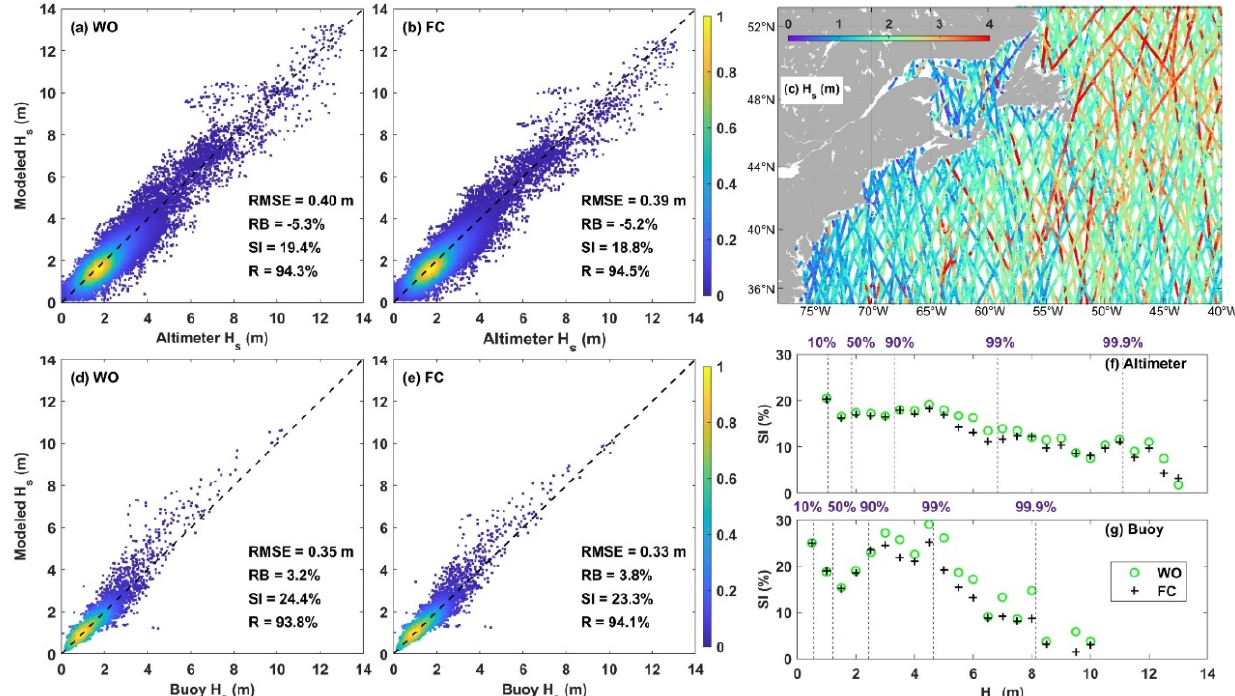
Figure 2. Scatterplots for SWHs between model results (( a , d ): run WO, ( b , e ): run FC) and observations (( a , b ): altimeters, ( d , e ): buoys). Values for the RMSE, RB, SI, and R are shown in each panel. The dashed black lines indicate the perfect fit. Colors represent the density of data points. ( c ) The SWHs along all the available altimeter tracks during the study period (from 20 August to 20 September 2010). Bin-averaged values of SI for runs FC and WO compared with the ( f ) altimeter and ( g ) buoy data in terms of wave states ( H s ). Dashed red lines in panels ( f , g ) indicate the SWHs at specific cumulative frequencies (10–99.9%).